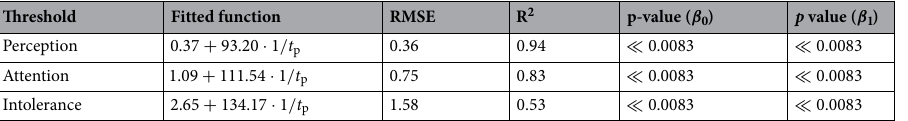
Table 2. Statistical analysis of the linear regression y = β 0 + β 1 · x with the auxiliary variable for the pulse width x = 1 / t p calculated for the perception, attention, and intolerance threshold evaluated by RMSE, R 2 , and a t-test of the regression coefficients β 0 and β 1 ( p